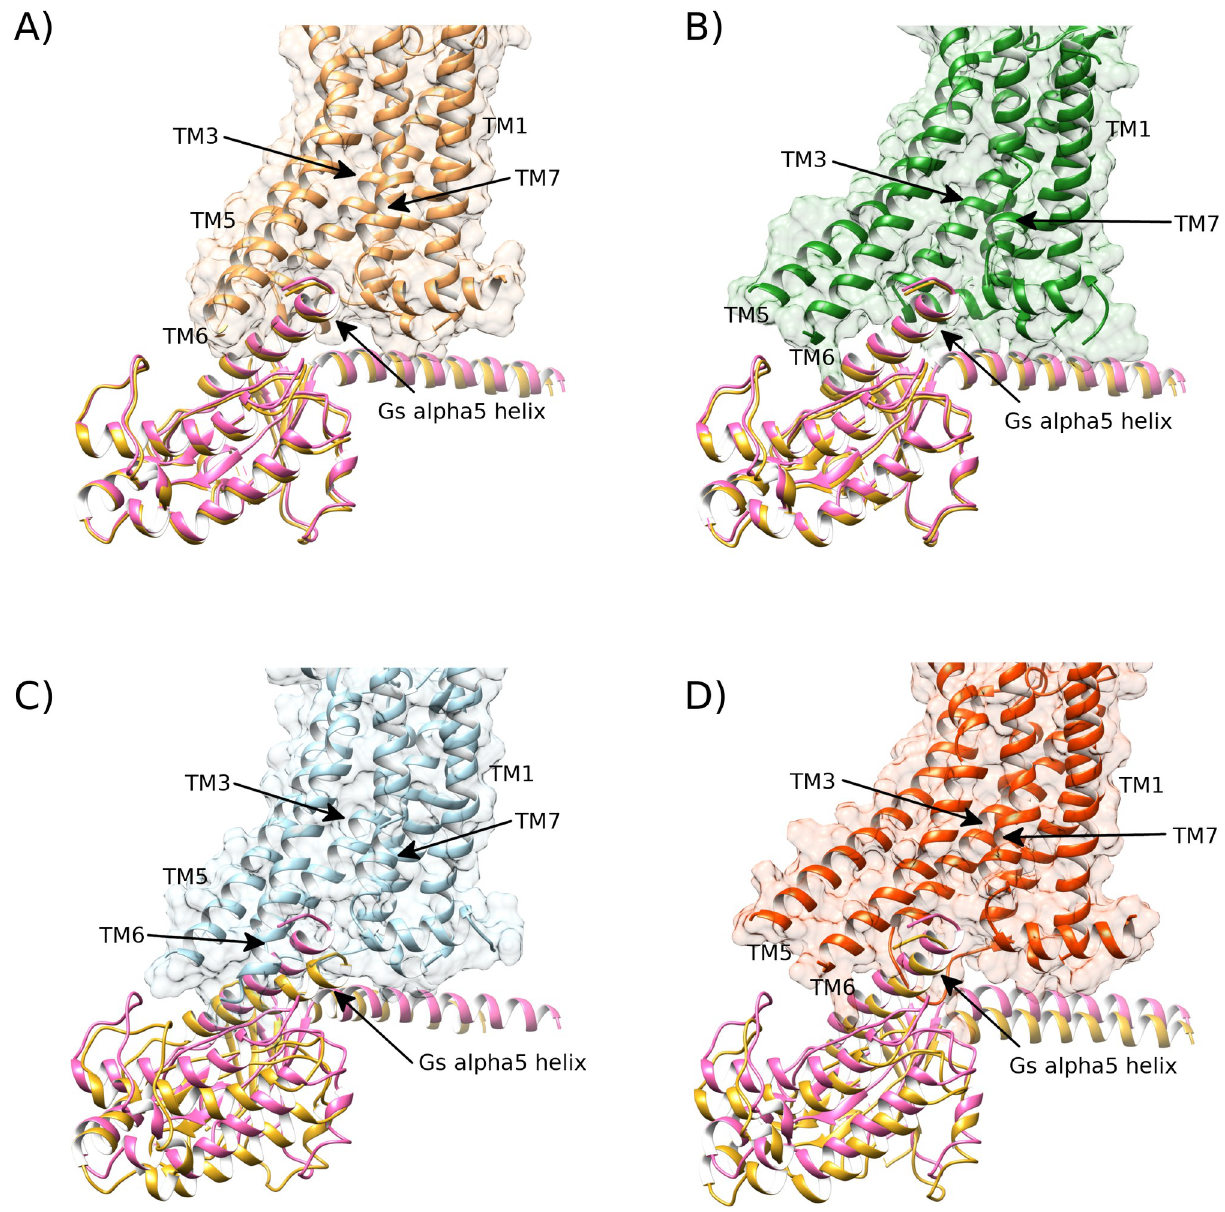
Fig 11. The MD-generated receptor conformation of A2aR bound to adenosine in DOPG membrane is able to bind co-crystallized G s -alpha protein in the same way as the active-state crystal structure (PDB id: 6GDG). A) The crystal structure of the active state of A2aR (brown) bound to its co-crystallized G s -alpha protein (pink, PDB id: 6GDG) and its re-docked G s -alpha subunit superimposed (gold). B) MD-generated active-like conformation of A2aR bound to adenosine in a DOPG membrane (green, belonging to replica #2 from 1.6 μ s) docks G s -alpha protein (gold) in similar fashion to the active crystal (pink). C) Intermediate conformation of A2aR, bound to adenosine in DOPC membrane (blue, belonging to replica #4 from 1.3 μ s) fails to properly dock G s -alpha protein (gold) compared to its active crystal position (pink). D) Intermediate conformation of apo A2aR in DOPG membrane (red, belonging to replica #1 from 1.6 μ s) partially docks G s -alpha protein (gold) compared to its active crystal position (pink).